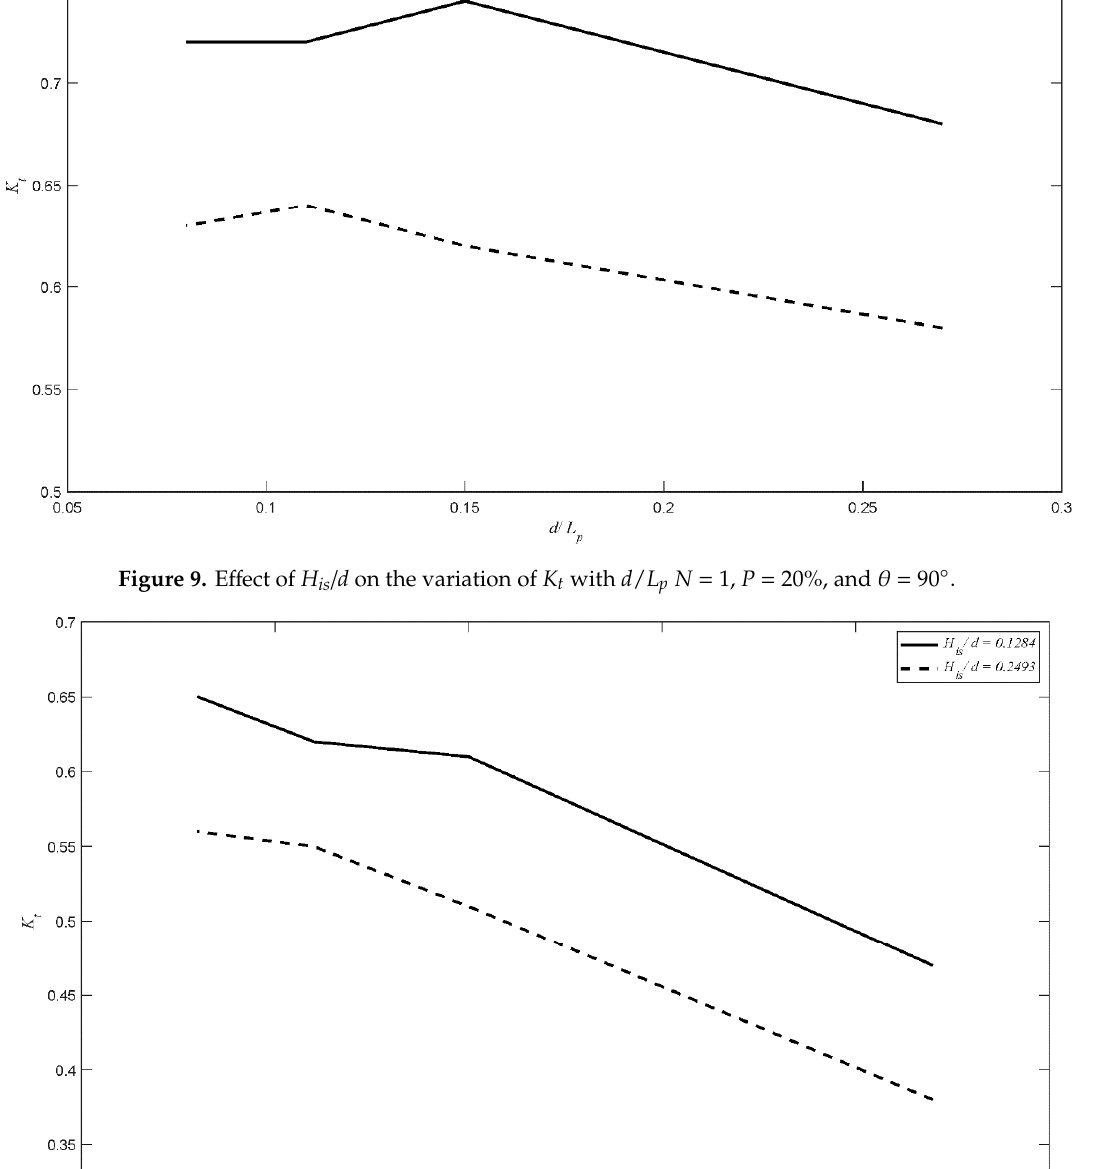
/ L = 2, P = 20%, and θ = 90 ◦ p , N t with d